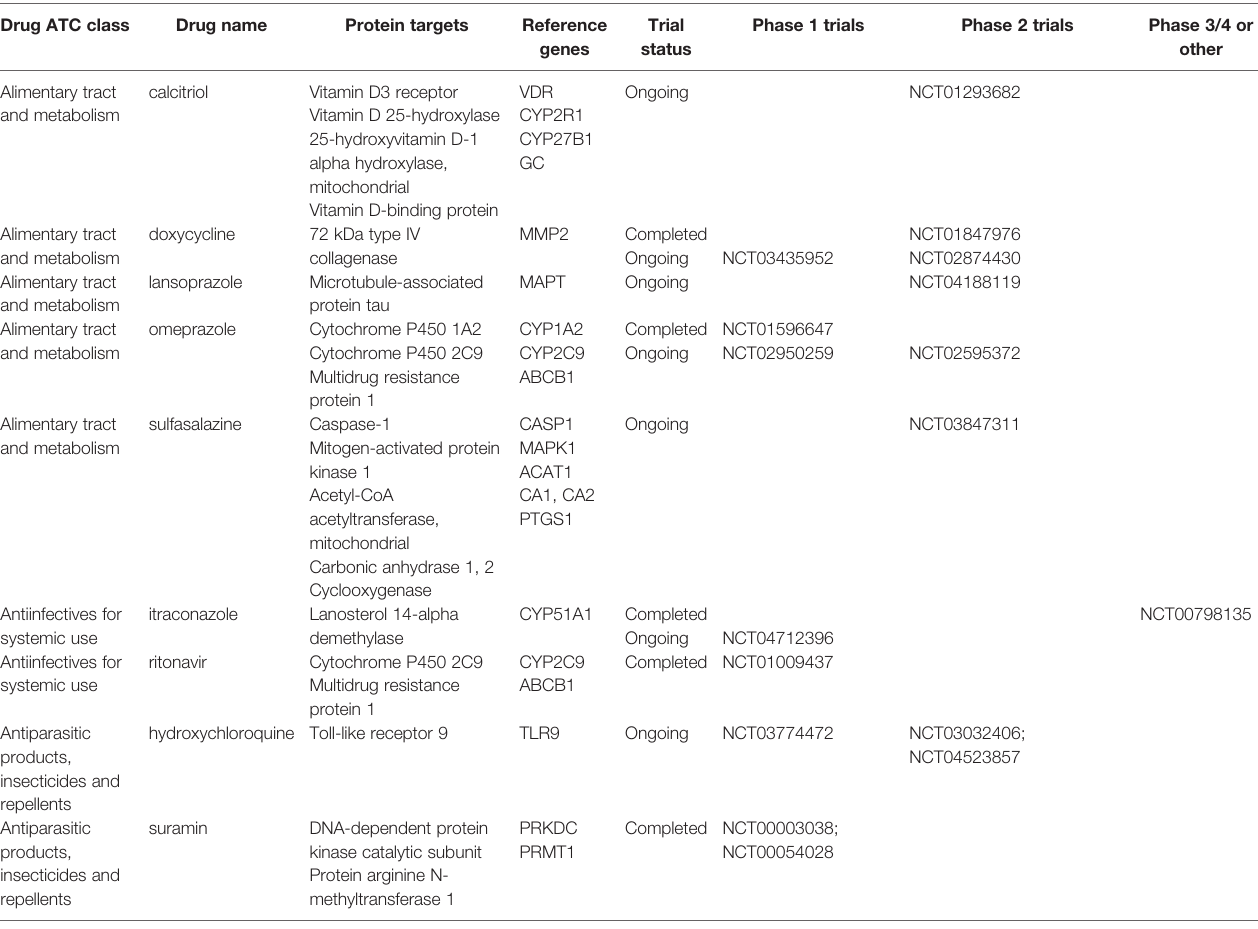
TABLE 4 | Non-anticancer drugs identi fi ed through the clonal proteome that are under clinical investigation in breast cancer patients for repurposing. Drug ATC